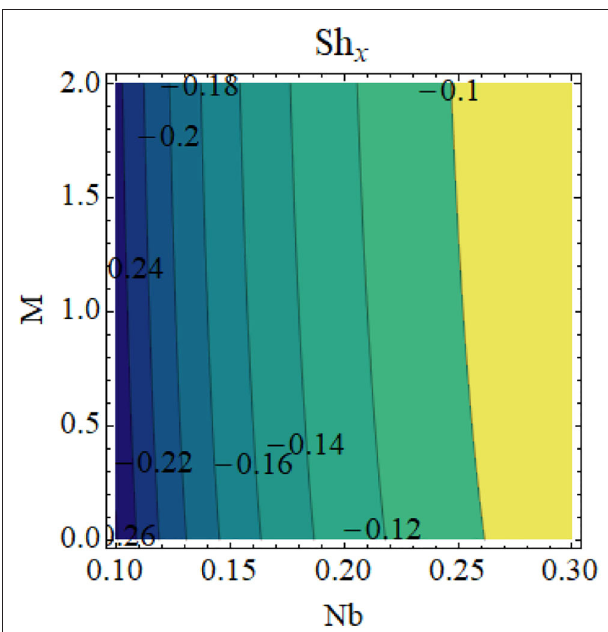
FIGURE 10 | Effects of Nb and M on Sh x .